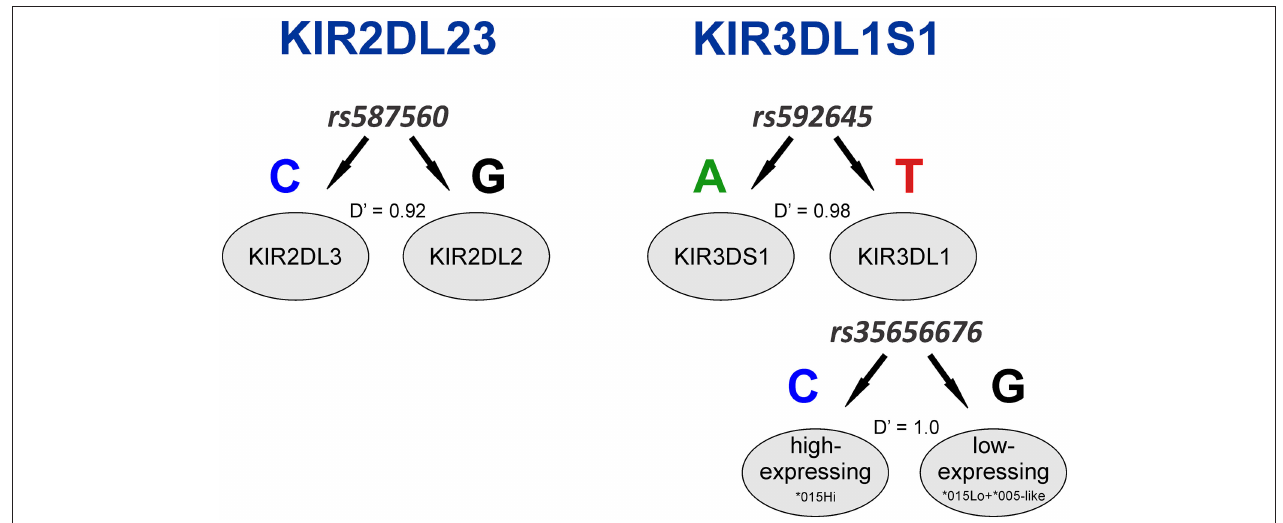
FIGURE 2 | Three SNPs define KIR2DL23 and KIR3DL1S1 allelic lineages. The SNP rs587560 ( KIR3DL3 intron 5) marks KIR2DL23 allelic lineages while the pair of SNPs rs592645 ( KIR2DL4 intron 4) and rs35656676 ( KIR2DL4 5’ UTR) defines the major KIR3DL1S1 lineages.